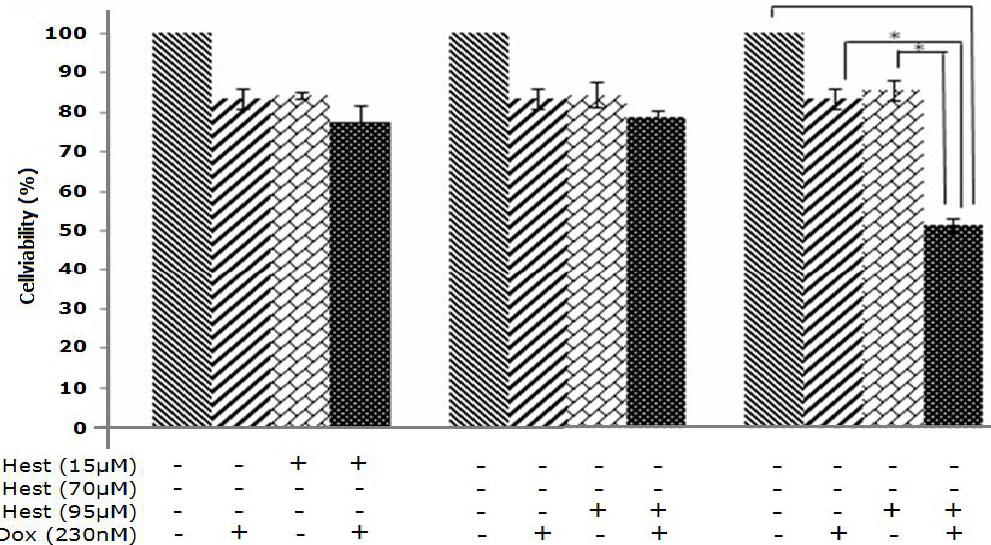
Figure 2. The effect of hesperetin and doxorubicin to MCF-7/DOX cells’ viability. Cells were seeded in 96-well plates at a density of 10x10 3 cells with hesperetin concentration 15µM (A), 70µM (B) and 95µM (C) and doxorubicin (230nM) towards MCF-7/DOX for 24h. After 24h, MTT reagent was added to calculate the absorbance which represents viable cells. Cell viability profile was shown from average ± standard of error (SE) of 3 experiments. * P <